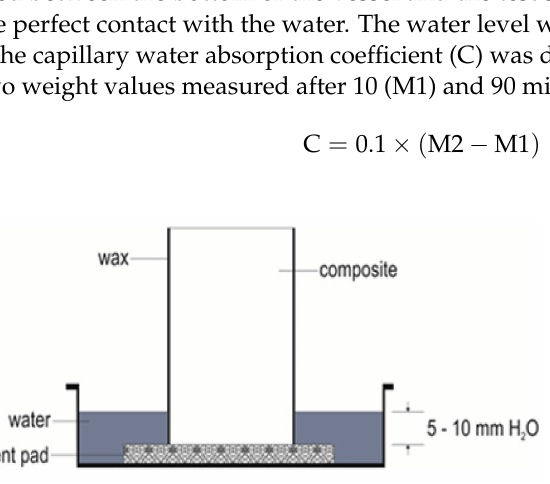
Figure 2. Capillary water absorption testing